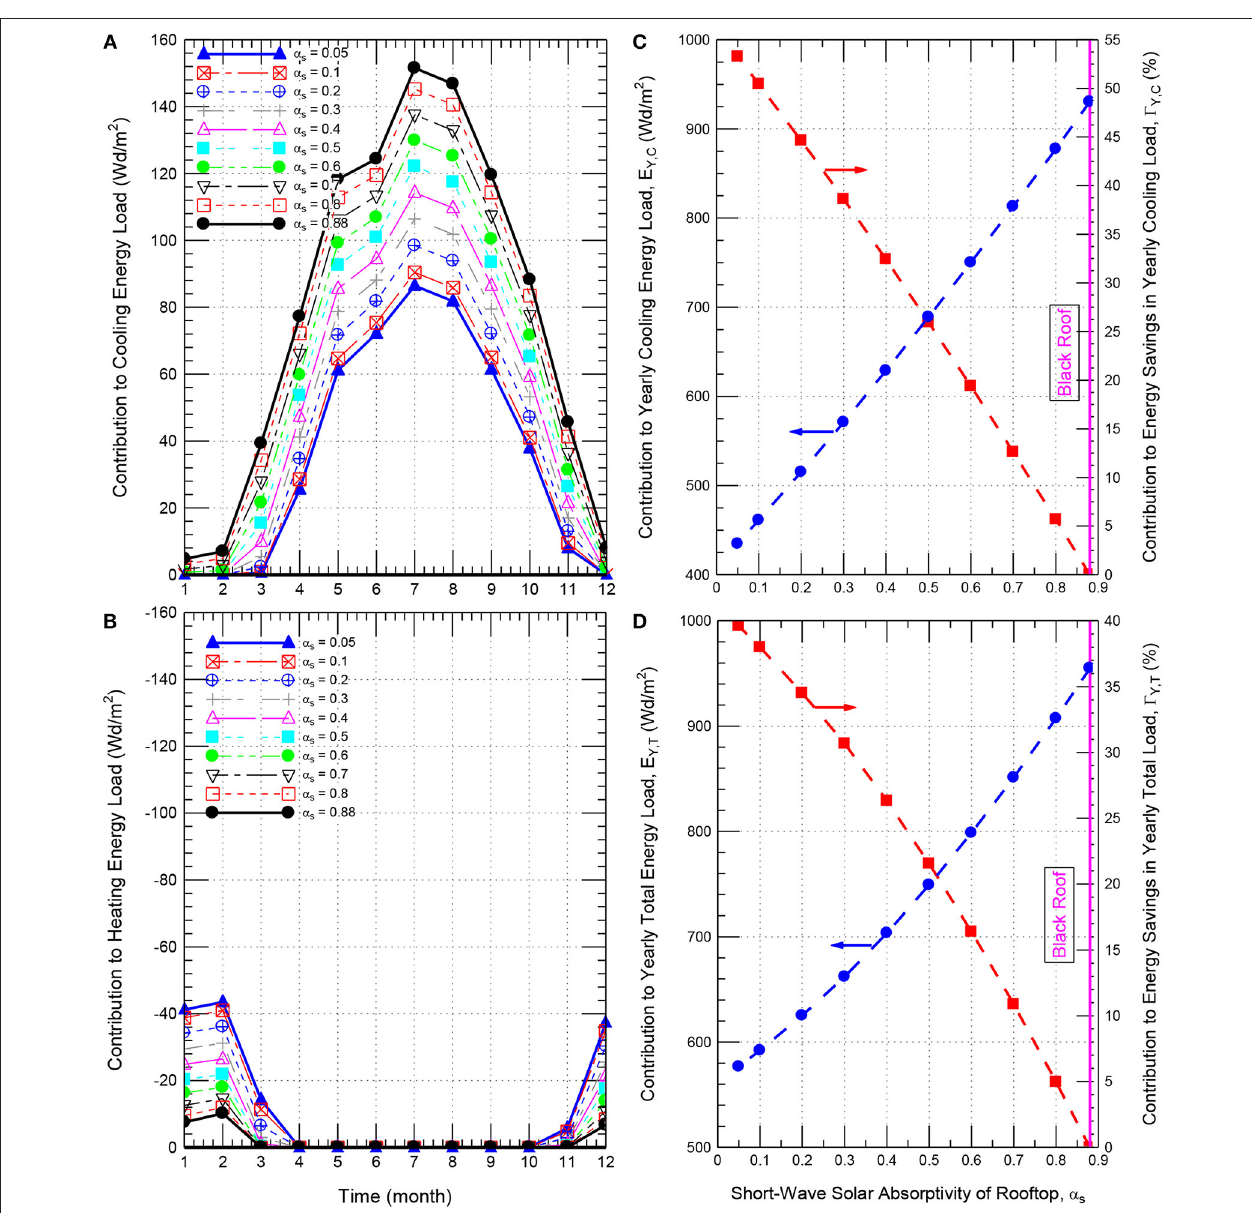
FIGURE 12 | Effect of the rooftop short-wave solar absorption coefficient on the contributions to the monthly cooling and heating energy loads (A,B) and yearly cooling and total energy loads (C,D) for roof having 1 ins = 152mm (6.0 inch).